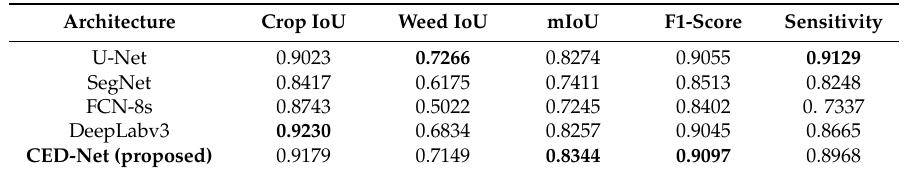
Table 5. Experimental results of the proposed approach for BoniRob dataset as opposed to other architectures (bold number represents the best results in the